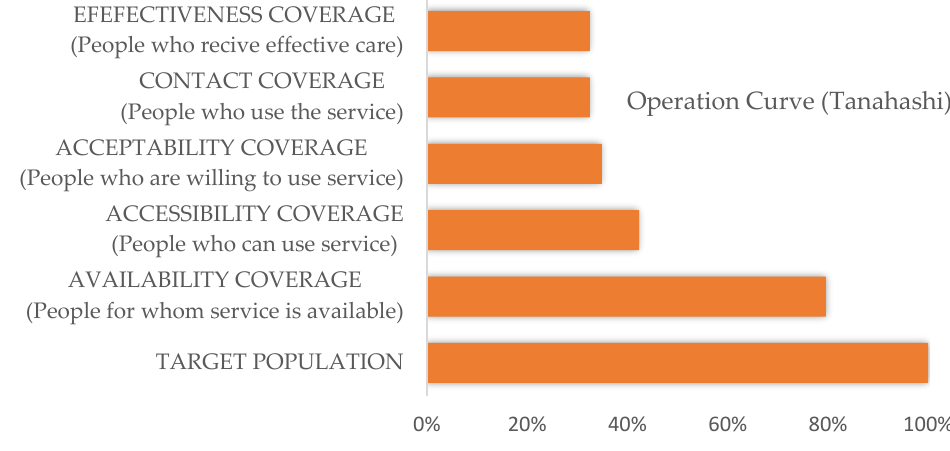
Figure 2. Operation curve according to the Tanahashi model.